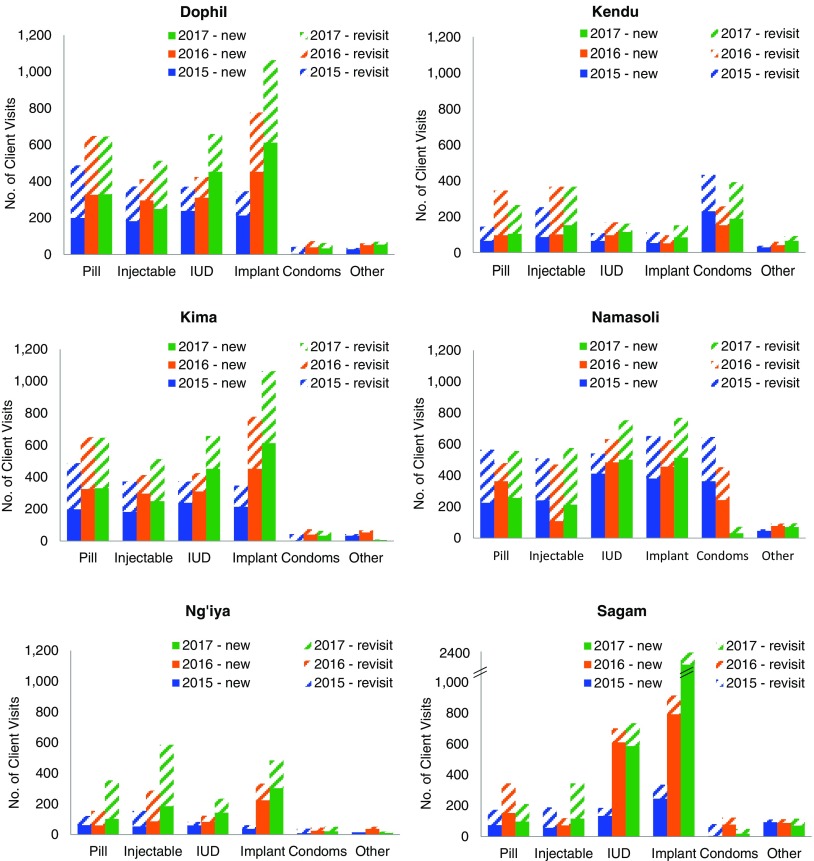
Number of Client Visits by New and Returning Visit and, Family Planning Method, and Facility, Kenya, Phase 2Abbreviation: IUD, intrauterine device.Note: “Other” includes CycleBeads, Lactational Amenorrhea Method (LAM), and female sterilization.